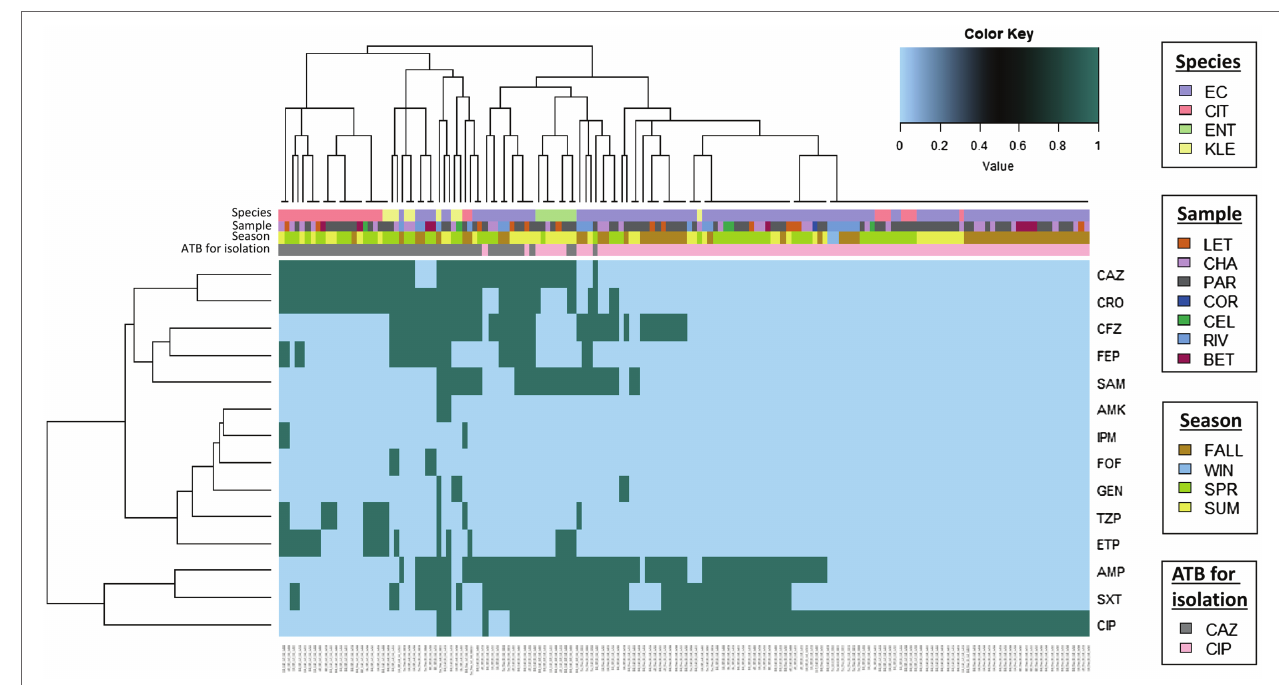
FIGURE 2 | Heat map representation of antimicrobial resistance (AMR) profiles. Cluster analysis of AMR profiles, in the vertical axis the abbreviations for the antimicrobial tested and in the horizontal axis are the isolates obtained in this study. Light blue represents sensitivity and dark green represents resistance. Five clusters were found and are labeled from 1 to 5 in the